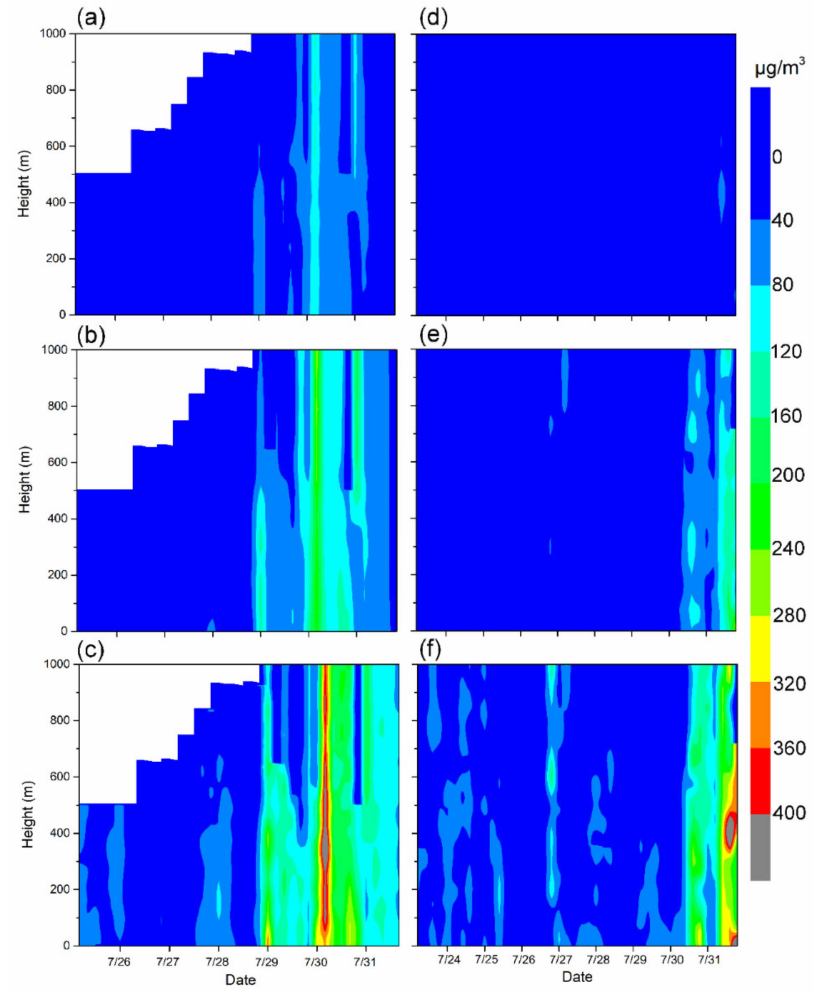
Figure 5. Vertical distributions of particle concentration with different sizes in MF (( a ), PM 1.0 ; ( b ), PM 2.5 ; ( c ), PM 10 ) and TZ (( d ), PM 1.0 ; ( e ), PM 2.5 ; ( f ), PM 10 ) during the observation